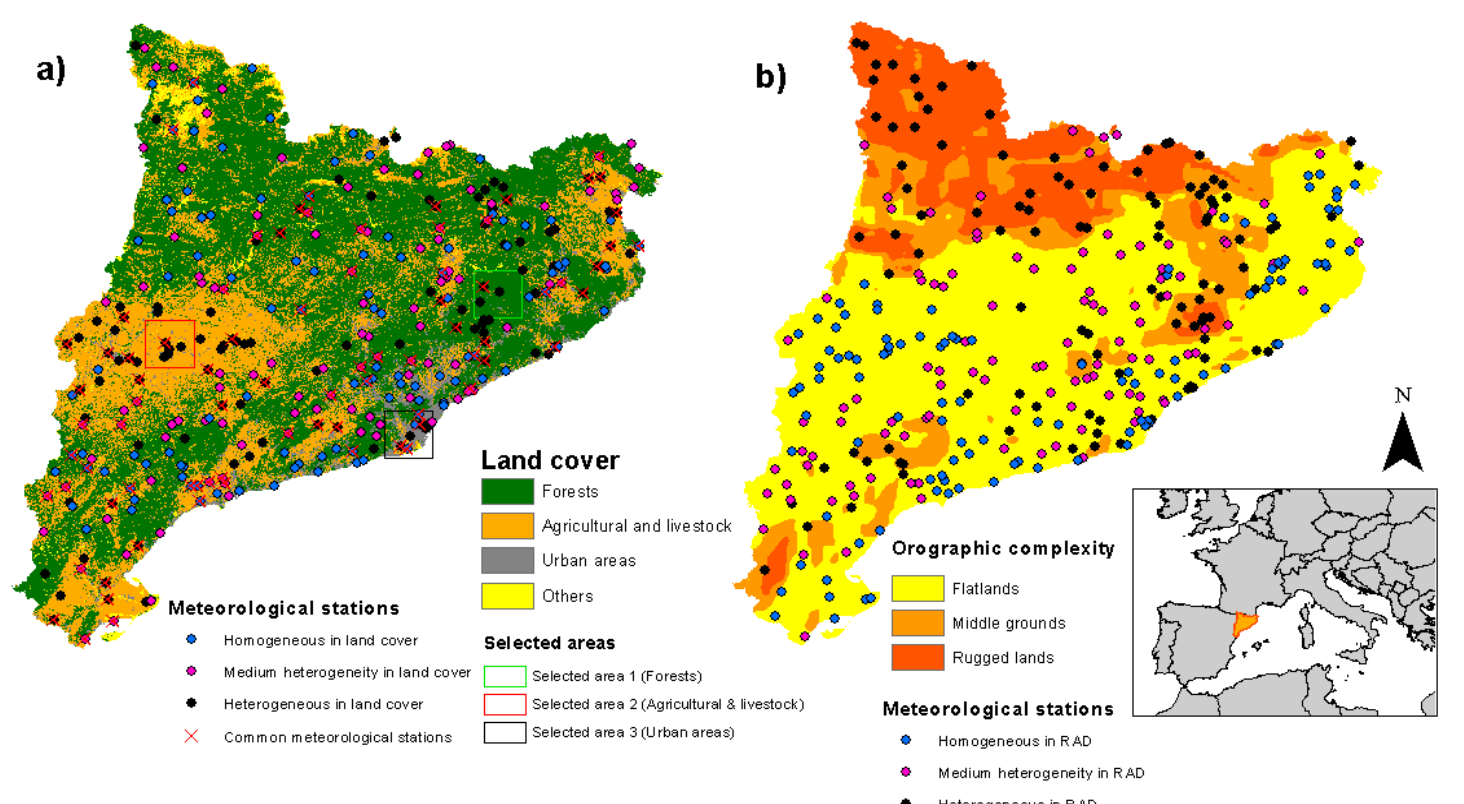
Figure 1. General view of Catalonia, northeast Iberian Peninsula, in Universal Transversal Mercator (UTM) projection. Classification in terms of: ( a ) land cover; and ( b ) orographic complexity are shown. The land cover map has been developed using orthophotographs obtained in 2009. The geographic location of the filtered meteorological stations is also shown, classified in terms of the heterogeneity level in: land cover ( a ) and; potential solar radiation ( b ), as well as the identification of meteorological stations common to all months ( a ). Three selected areas of the image, characteristic of a predominant land cover, are also identified. Because each month and case has a different number of meteorological stations, we represented the case with the maximum number of meteorological stations (maximum T air in March 2014).